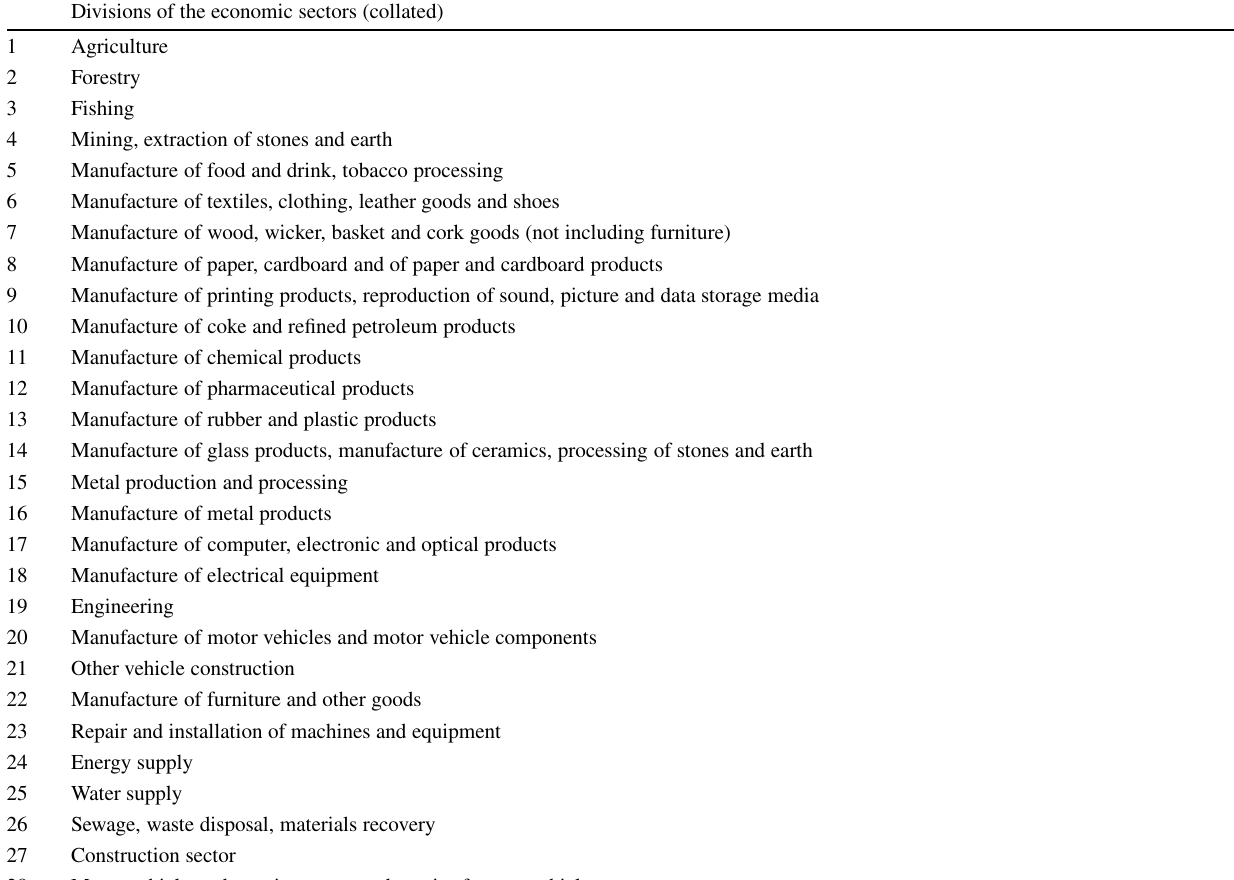
Table 6 Structure of the NACE Rev. 2 Classification of Economic Activities used in the Projection Divisions of the economic sectors